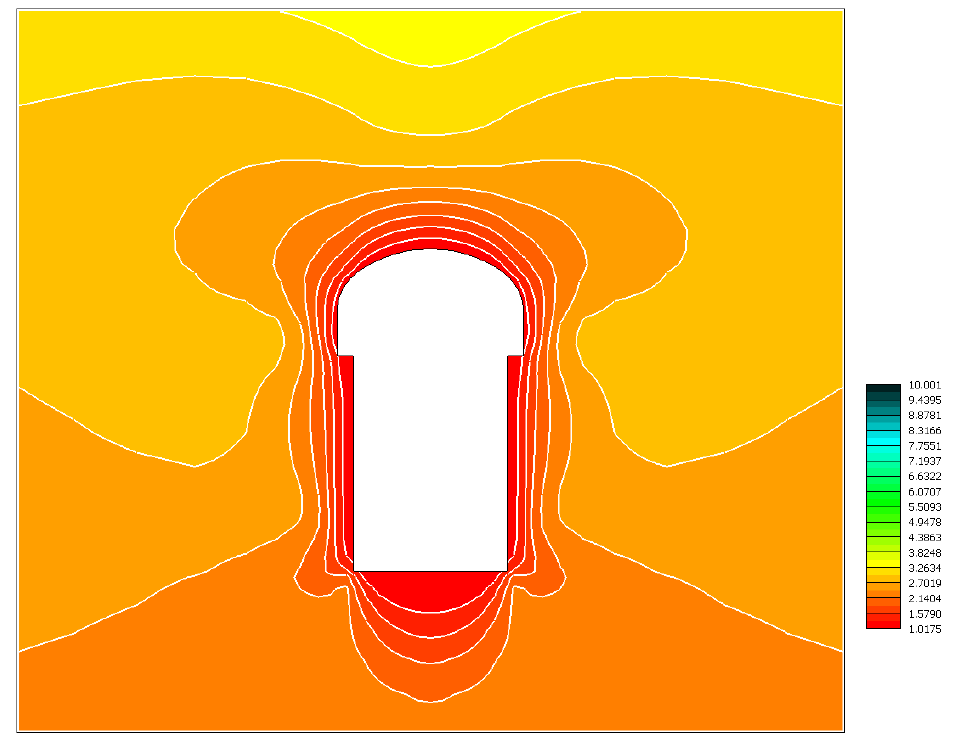
Figure 20. Safety factor distribution (Ko = 2.0).